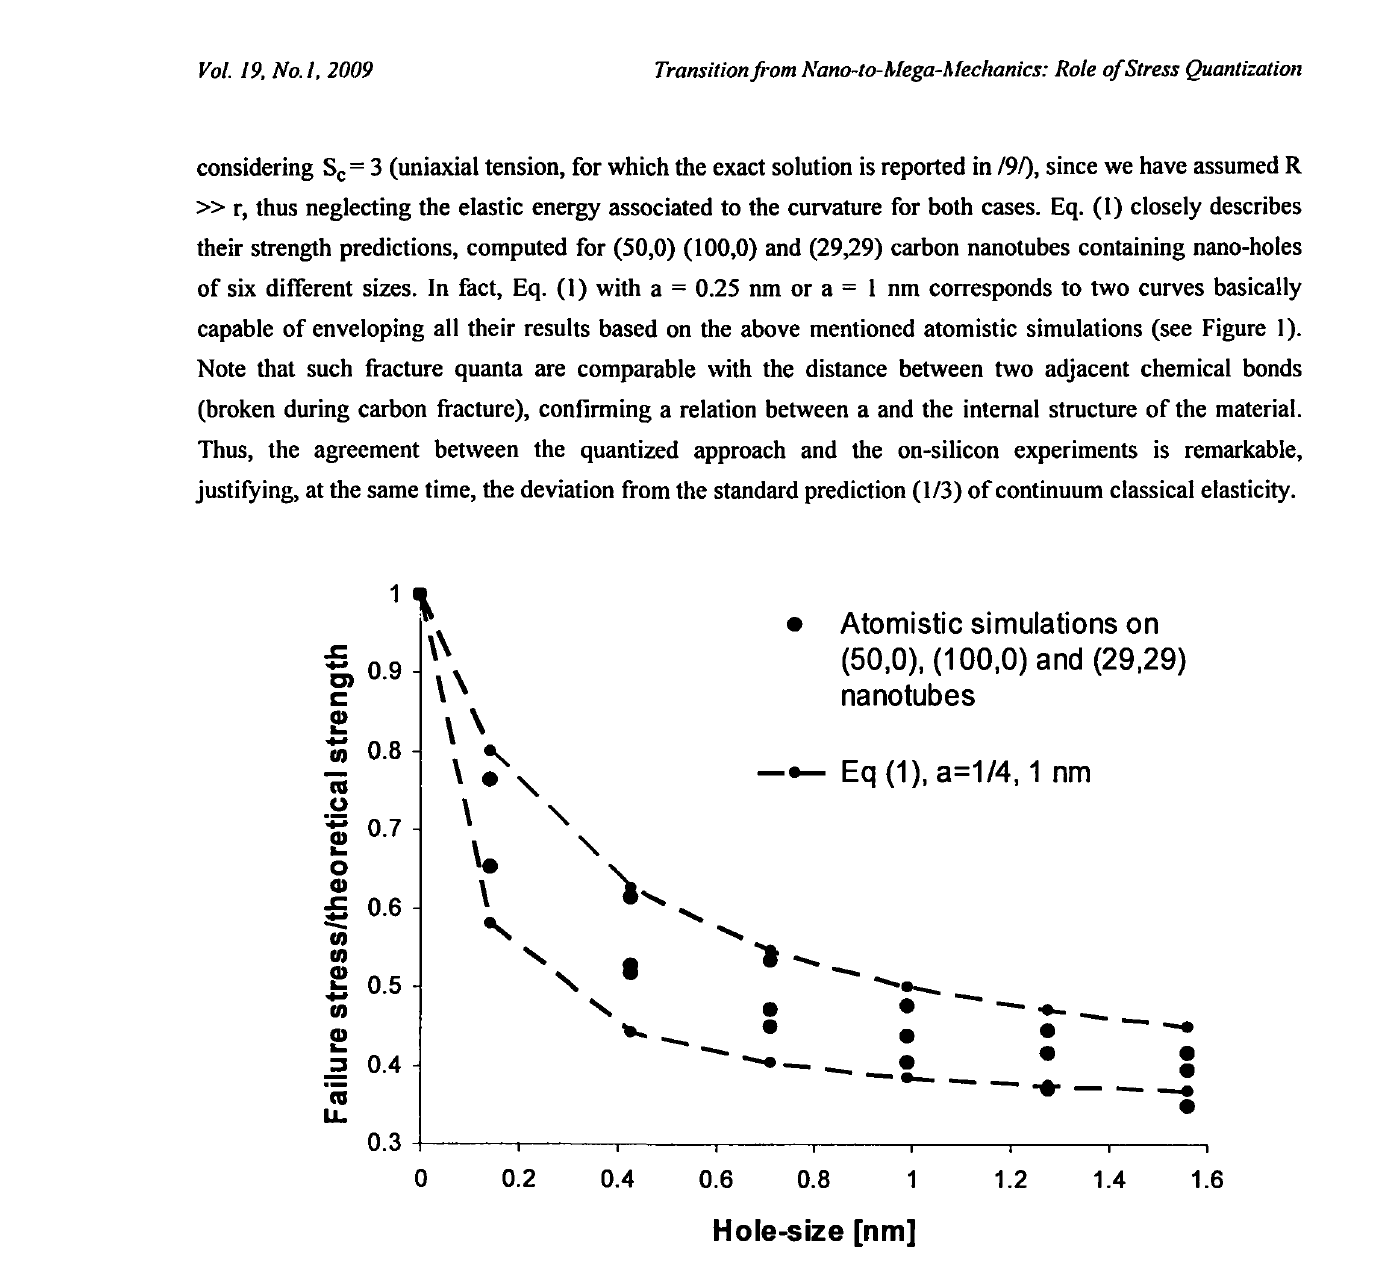
Fig. 1: Atomistic simulations [13, 14] interpreted here by assuming a stress quantization (Eq. (1) with a = 0.25 nm and a = 1 nm, respectively). Note that classical elasticity (i.e. the continuum counterpart of the "quantized" approach) would trivially yield a straight horizontal line at 1/3, independently of the hole-size. Thus, the role of the stress quantization is